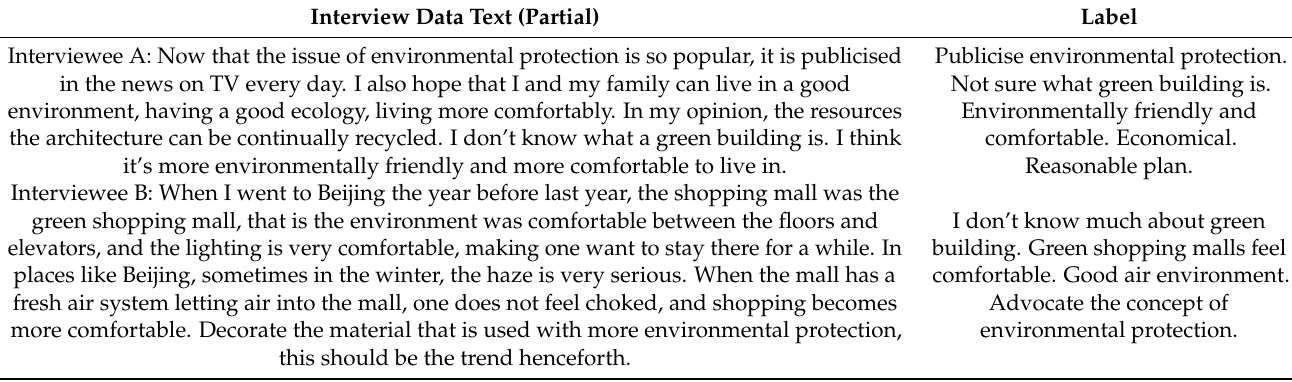
Table 2. Interview material text and labelling examples (partial content).